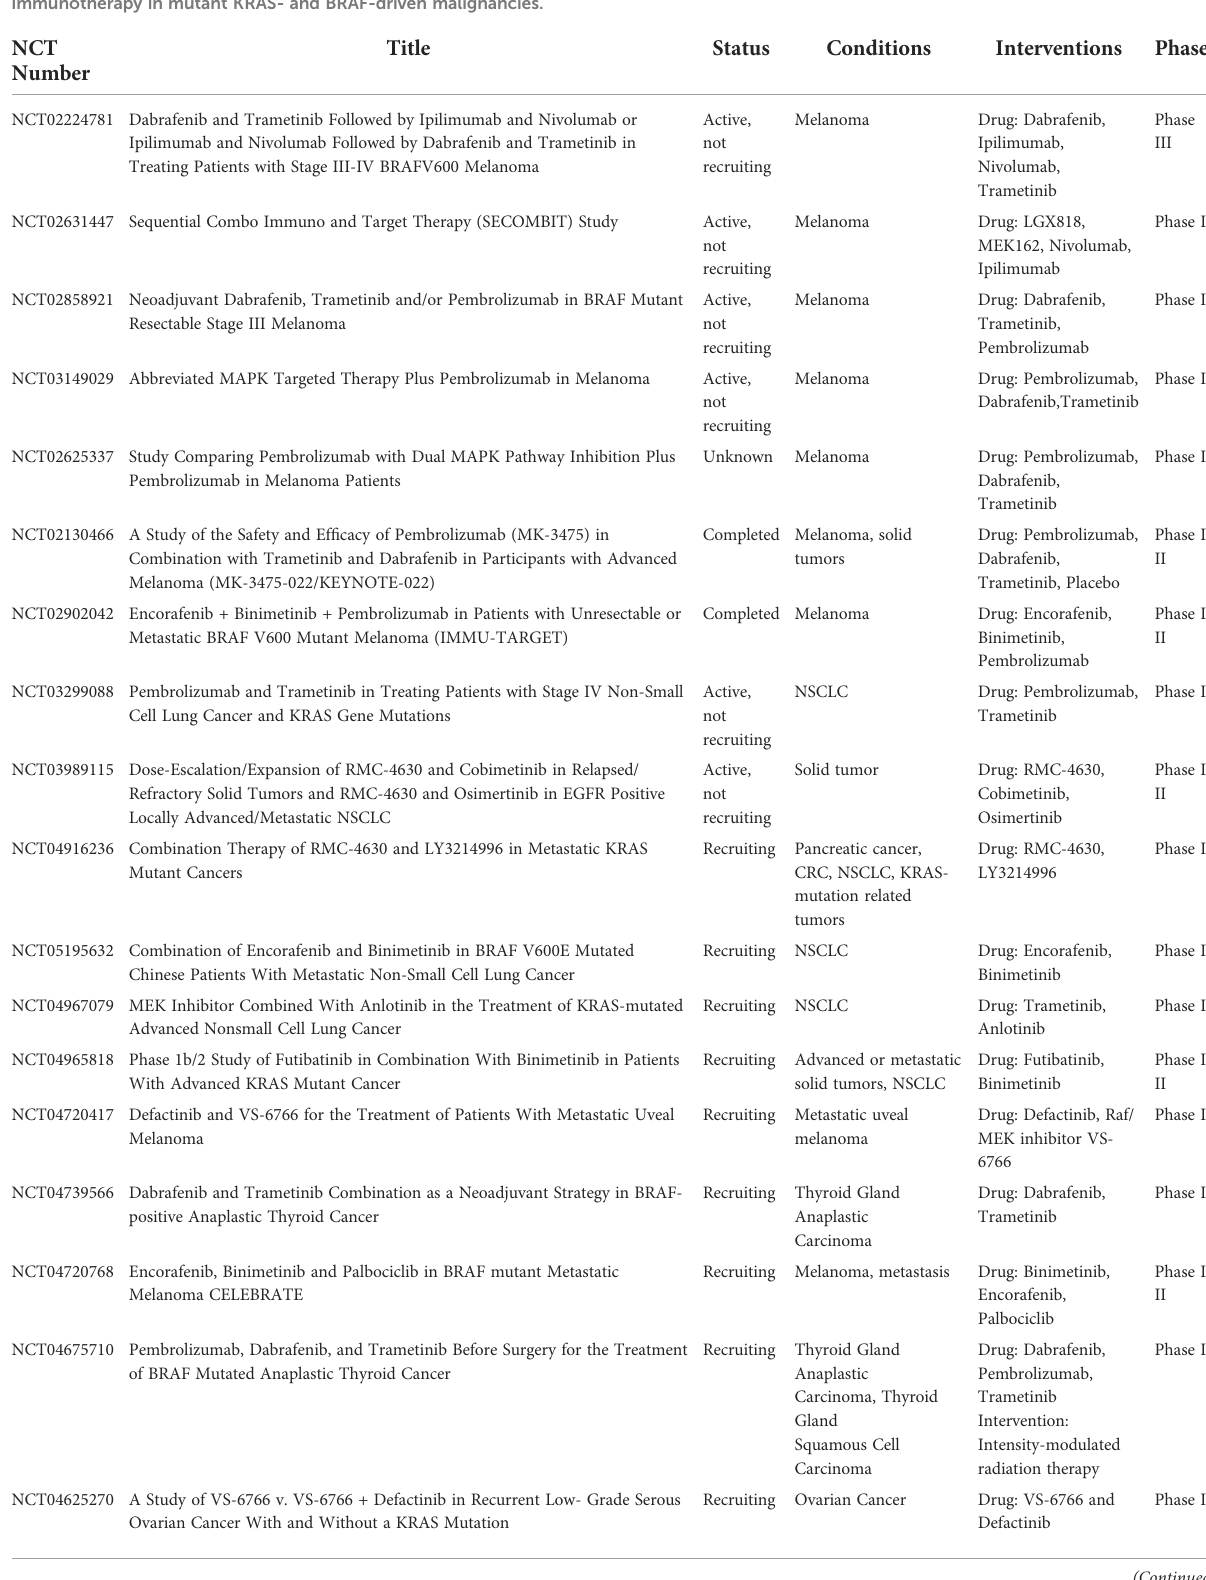
TABLE 2 Overview of currently active clinical trials investigating various combinations of MEK inhibition, other small molecule inhibitors and immunotherapy in mutant KRAS- and BRAF-driven